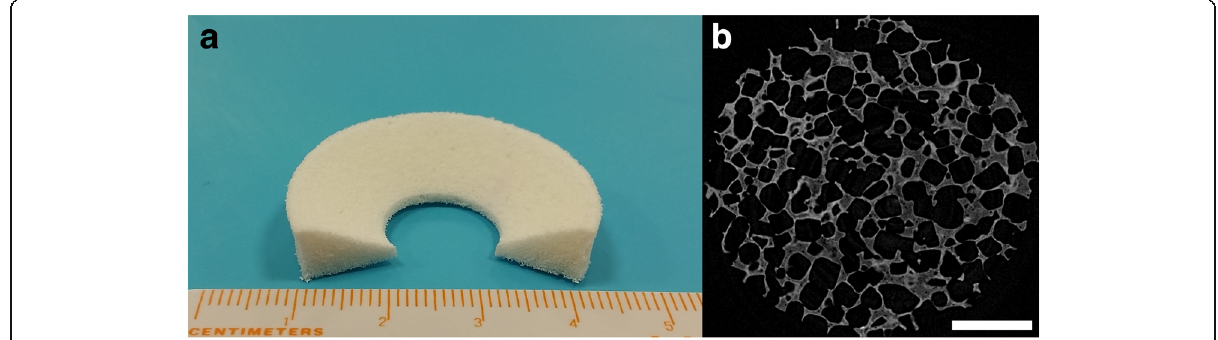
Fig. 4 A photograph ( a ) and micro-structural image ( b ) of a commercially available polycaprolactone-polyurethane scaffold (Actifit; Orteq Bioengineering, London, UK) for meniscus. The scale bar indicates 1